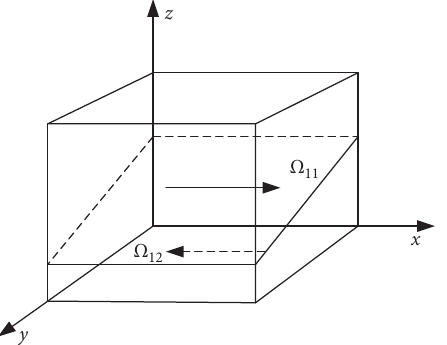
Figure 2: Dynamic evolution of government decision